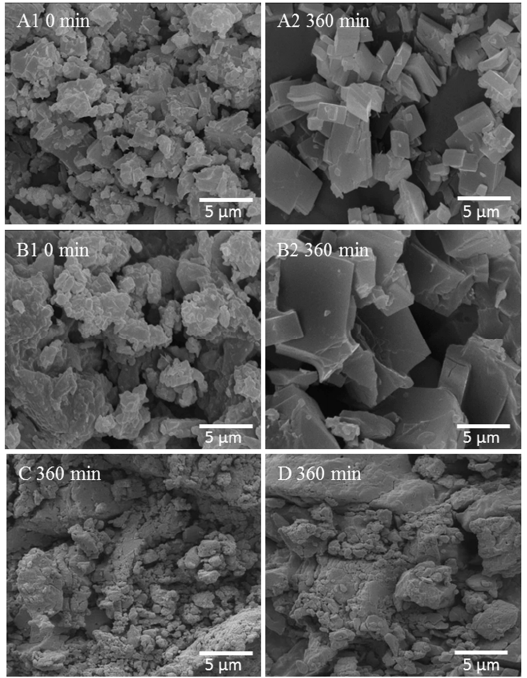
Figure 5. Micrographs of wet masses for formulations A, B 1 , C and D 1 . Formulation A ( t = 0 min ( A1 ) and t = 360 min ( A2 ); Formulation B 1 ( t = 0 min ( B1 ) and t = 360 min ( B2 )); Formulation C ( t = 360 min ( C )); Formulation D 1 ( t = 360 min ( D )).